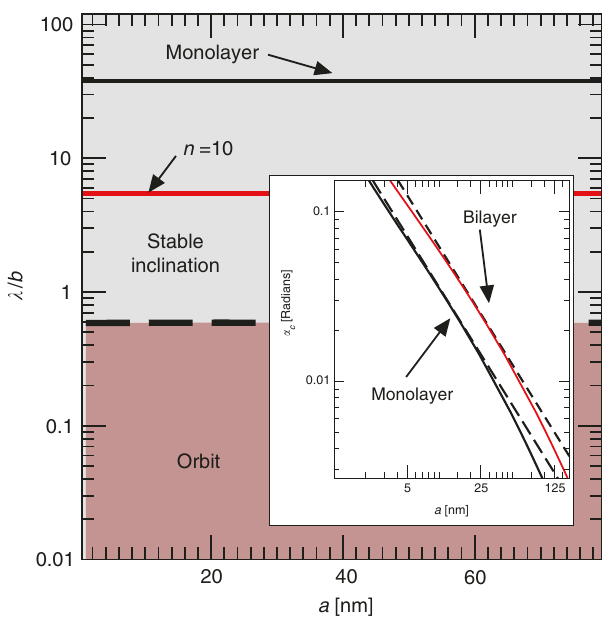
Fig. 7 Stability phase diagram. Regimes of rotational dynamics (periodic orbit as predicted by Jeffery ’ s orbit, or stable inclination) as a function of the slip length and aspect ratio for a graphene monolayer. Full lines are λ / b for λ = 10 nm and: n = 1 (black line); n = 10 (red line). These platelets are well within the region of ‘ stable inclination ’ . The simulations suggest that the critical slip length separating the two regions is comparable to λ c ~ b . Inset: Critical inclination angle α c vs length of nanoplatelets for a monolayer ( n = 1) (black line) and bilayer ( n = 2) (red line) with a fi xed slip length λ = ffiffiffiffiffiffiffi p b = a 60 nm. Dashed (black) line is the estimate c